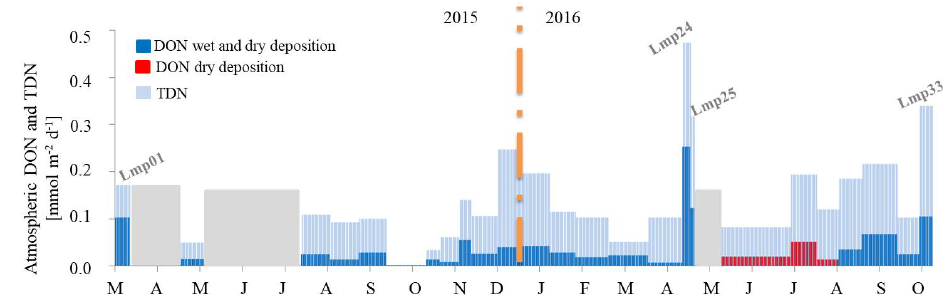
Figure 3. Atmospheric DON and TDN deposition. Gray areas correspond to the periods with no data. The month abbreviation and tick marks correspond to the end of the corresponding month. The width of the bar refers to the length of the sampling